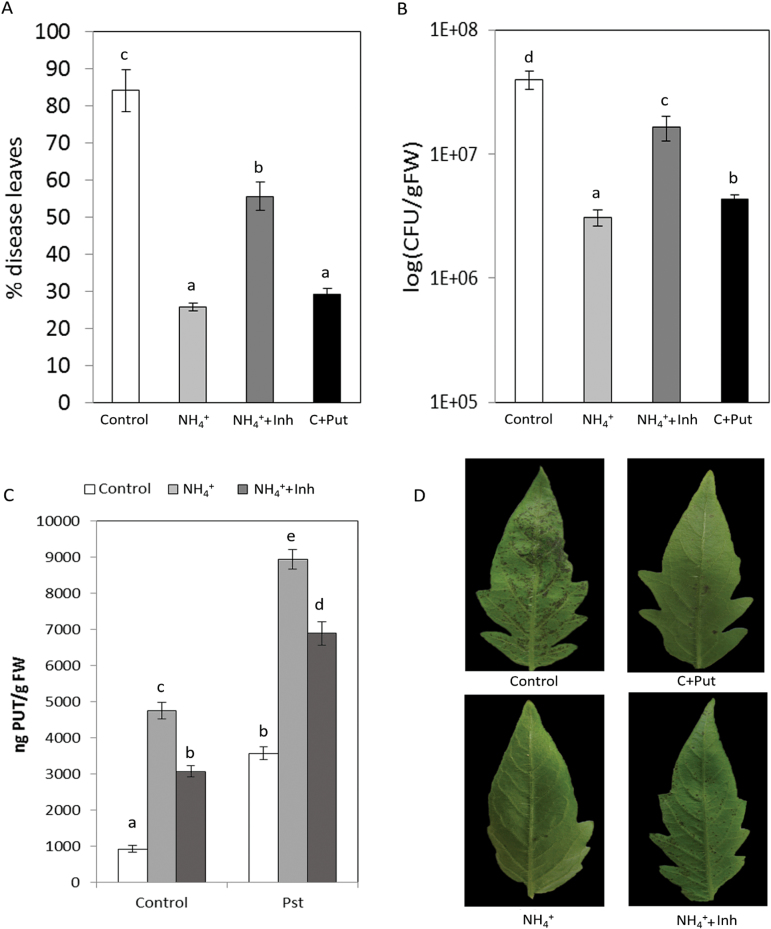
Influence of Put accumulation on NH4
+-IR against Pst. Plants were grown as described in Fig. 2 and, 1 week prior to inoculation, N-NH4
+ plants were treated with inhibitor solution (containing DFMO and DFMA; NH4
++Inh) and control plants were treated with 0.5mM Put 48h before infection (C+Put), and inoculated by dipping them in a bacterial suspension of Pst at 5×105 cfu ml−1. The disease rating was scored by measuring the percentage of infected leaves in relation to the total number of analysed leaves (A) and by recounting of bacterial populations by plating in agar–KB medium (B) at 72 hpi. The Put level in control, NH4
+, and NH4
++Inh plants was analysed at 48 hpi (C). The photograph shows a representative picture of disease symptoms in control, NH4
+, NH4
++Inh, and C+Put tomato leaves at 72 hpi (D). Data show the average of three independent experiments of a pool of 10 plants per experiment ±SE. Letters indicate statistically significant differences (P<0.05; least-significant difference test). (This figure is available in colour at JXB online.)